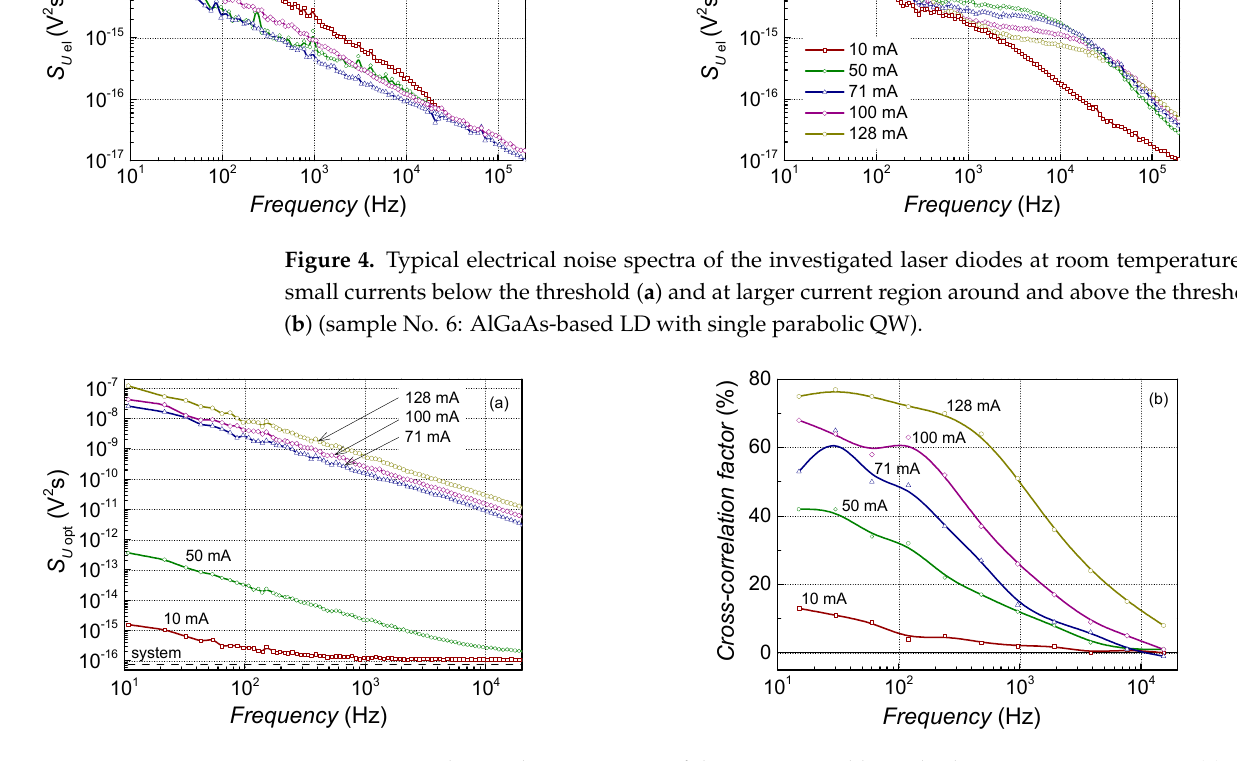
Figure 5. Typical optical noise spectra of the investigated laser diodes at room temperature ( a ) and cross-correlation factor dependency on the frequency at room temperature ( b ) (sample No. 6: AlGaAs-based LD with single parabolic QW; the “system” corresponds to the noise level of the measuring system, which for optical noise measurement is determined by the value of the thermal noise of the photodetector load resistance).